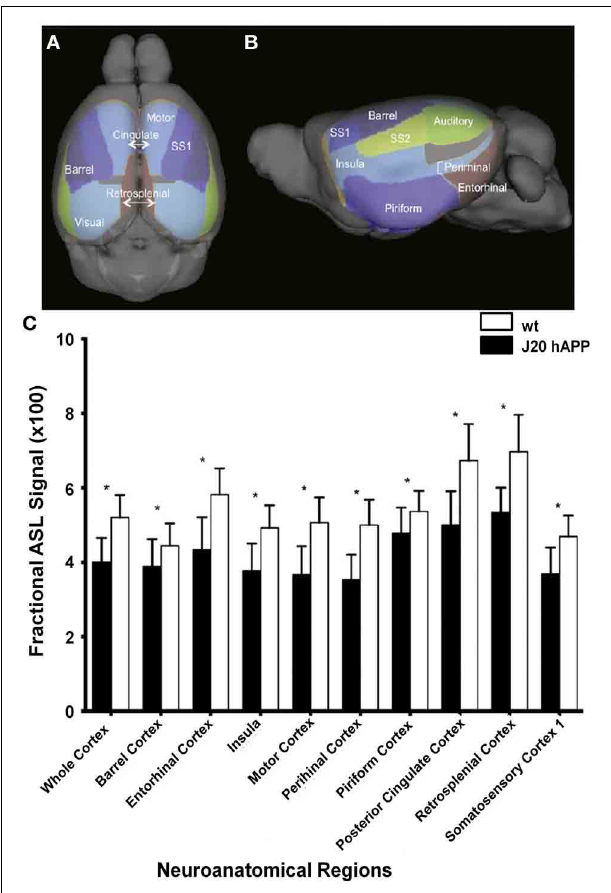
FIGURE 5 | Hypoperfusion in 3-month-old J20 hAPP mice modeling AD. Superior (A) and lateral (B) views of the cortical surface atlas with 14 regions-of-interest labels derived from high resolution 3D MRI data sets. (C) ASL perfusion MRI measurements from representative regions-of-interest in young transgenic and age-matched wild-type mice. Note that the whole cortex and most regions demonstrated significantly lower perfusion ( ∗ p < 0 . 05) in J20 hAPP compared with wild-type animals. Modified with permission from Hébert et al. (2013), © 2013 Elsevier Inc.